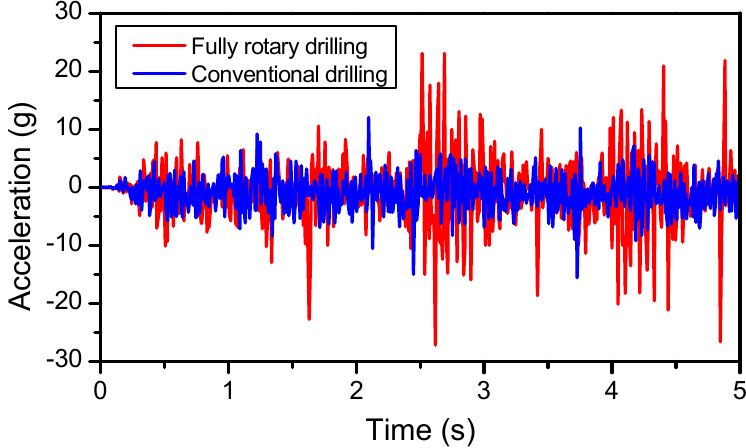
Figure 6. Lateral acceleration versus time on the BHA for both fully rotary and conventional drilling.